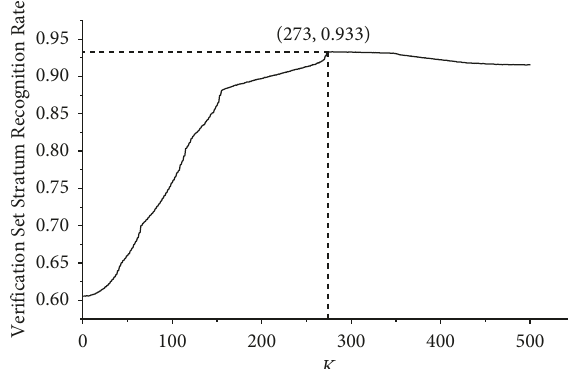
Figure 6: Relationship between the K value and formation rec- ognition